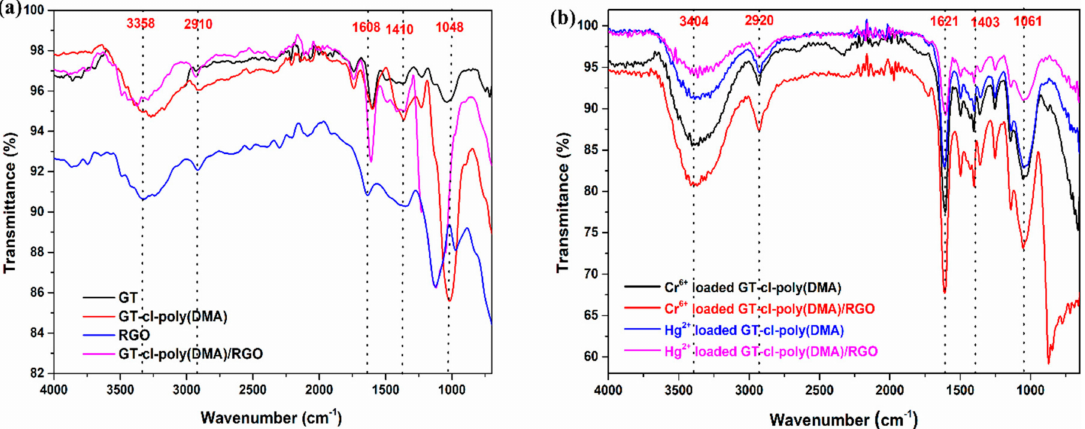
Figure 2. Fourier transform infrared of ( a ) gum tragacanth (GT), gum tragacanth-cl- N,N - dimethylacrylamide (GT-cl-poly(DMA)) hydrogel, RGO and reduced graphene oxide incorporated gum tragacanth-cl- N,N -dimethylacrylamide (GT-cl-poly(DMA) / RGO) hydrogel composite, ( b ) Hg 2 + and Cr 6 + loaded GT-cl-poly(DMA) hydrogel and GT-cl-poly(DMA) / RGO hydrogel